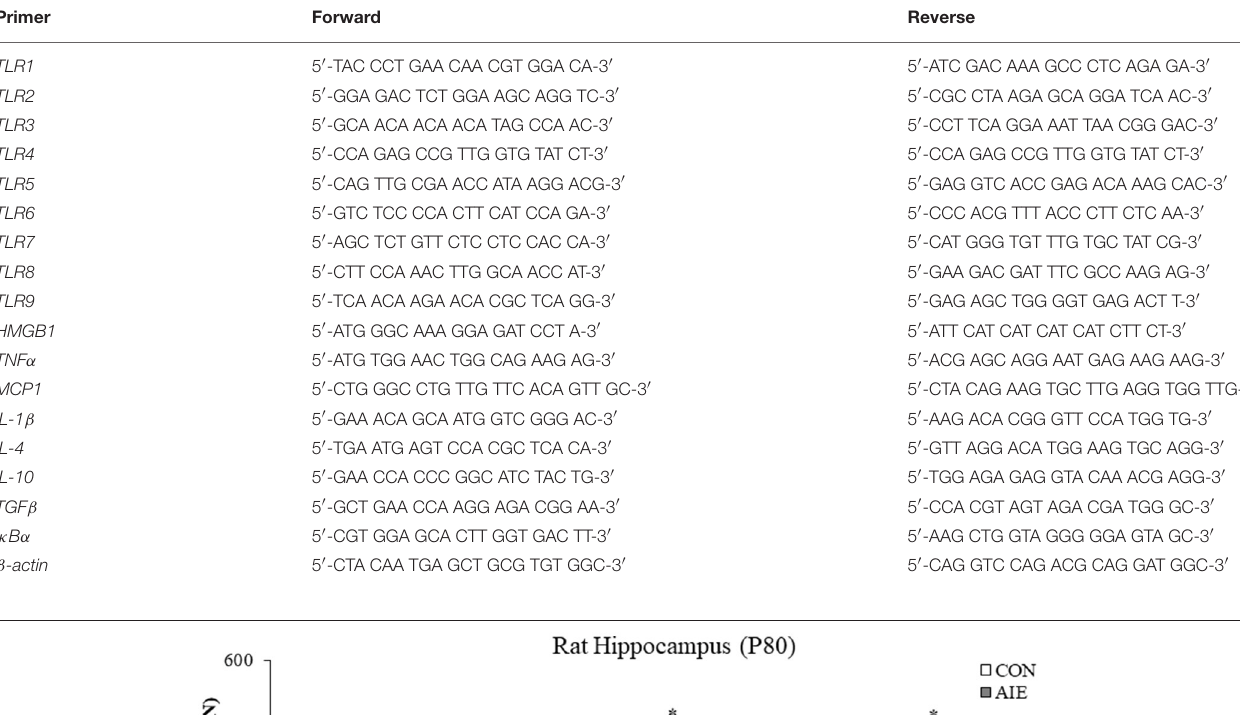
TABLE 2 | List of primers for rat qPCR.